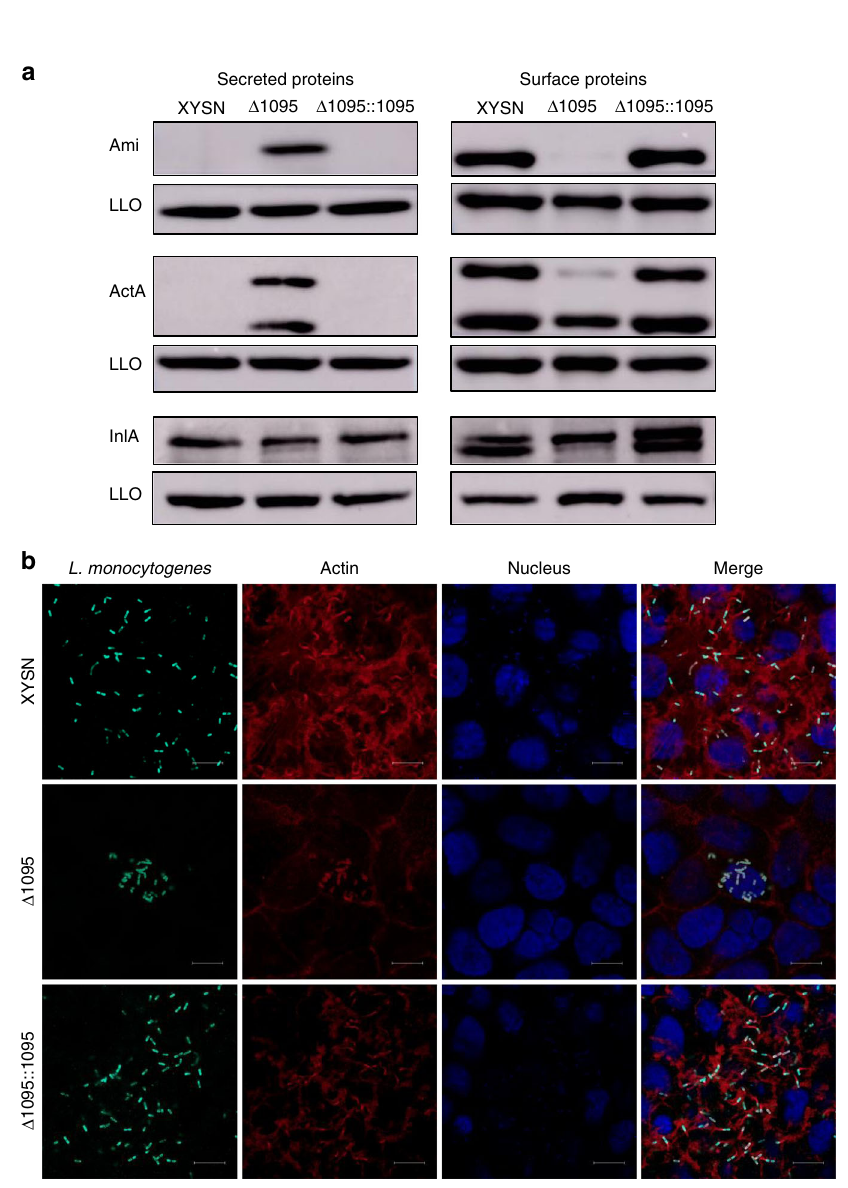
Fig. 6 WTA galactosylation promotes association of Ami, ActA and InlA to the surface of Lm. a Surface-associated and secreted Lm proteins extracts were obtained from XYSN, Δ 1095, and Δ 1095::1095. LLO protein levels were used as sample loading control. The image presented is representative of three independent experiments. b Confocal images of XYSN, Δ 1095, Δ 1095::1095 in Caco-2 BBe cells at 7 h-post infection. ActA was visualized with an anti- ActA monoclonal antibody and goat Anti-Mouse Alexa Fluor 488-conjugated IgG (green), the actin cytoskeleton was stained by phalloidin (red), and DNA was stained by DAPI (blue) following fi xation and permeabilization of the sample. Magni fi cation of all images: ×1000. Scale bars, 10 μ m